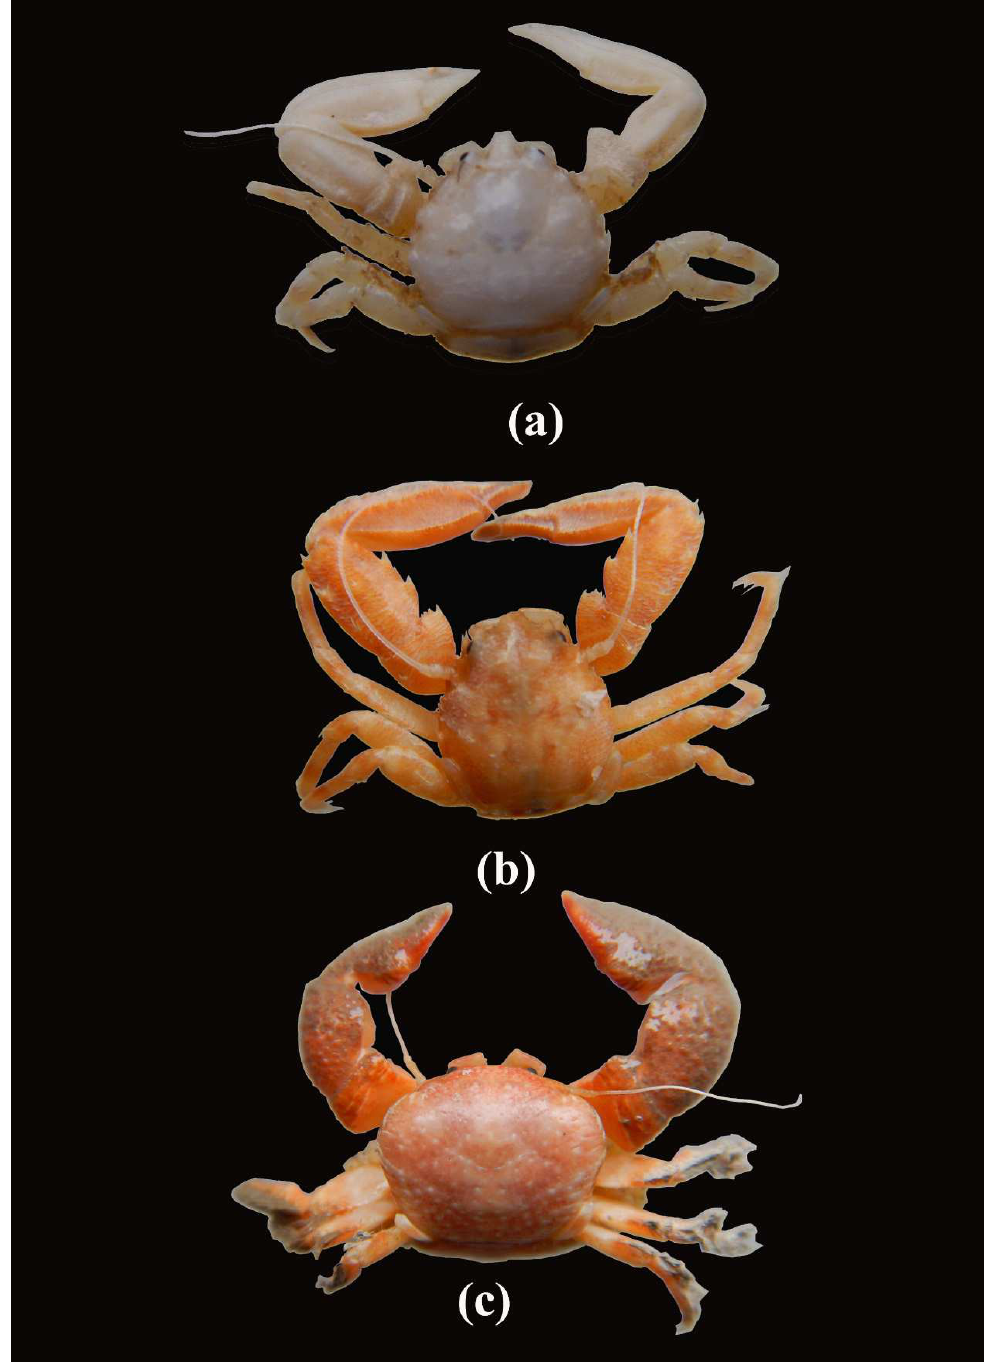
F IGURE 3. Entire animal dorsal view (a) Pisidia dehaanii , male, CL: 3.0 mm, CW: 3.1 mm. (b) Pisidia gordoni , male, CL: 5.5 mm, CW: 4.0 mm (c) Polyonyx hendersoni , female, CL: 6.4 mm, CW: 6.8